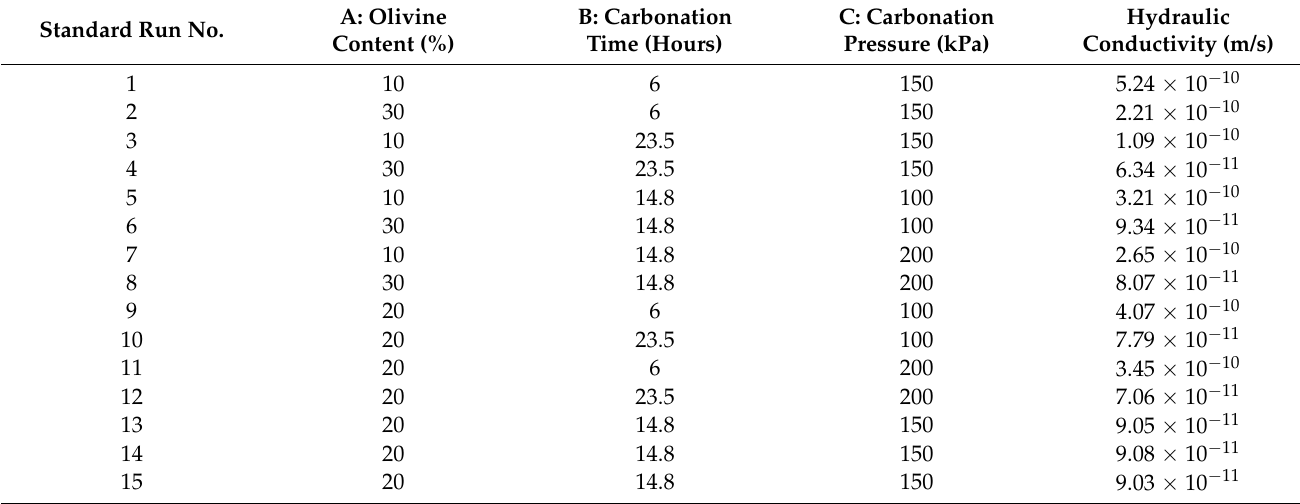
Table 4. Experimental design matrix with independent variables expressed in actual units and experimental response. Standard Run